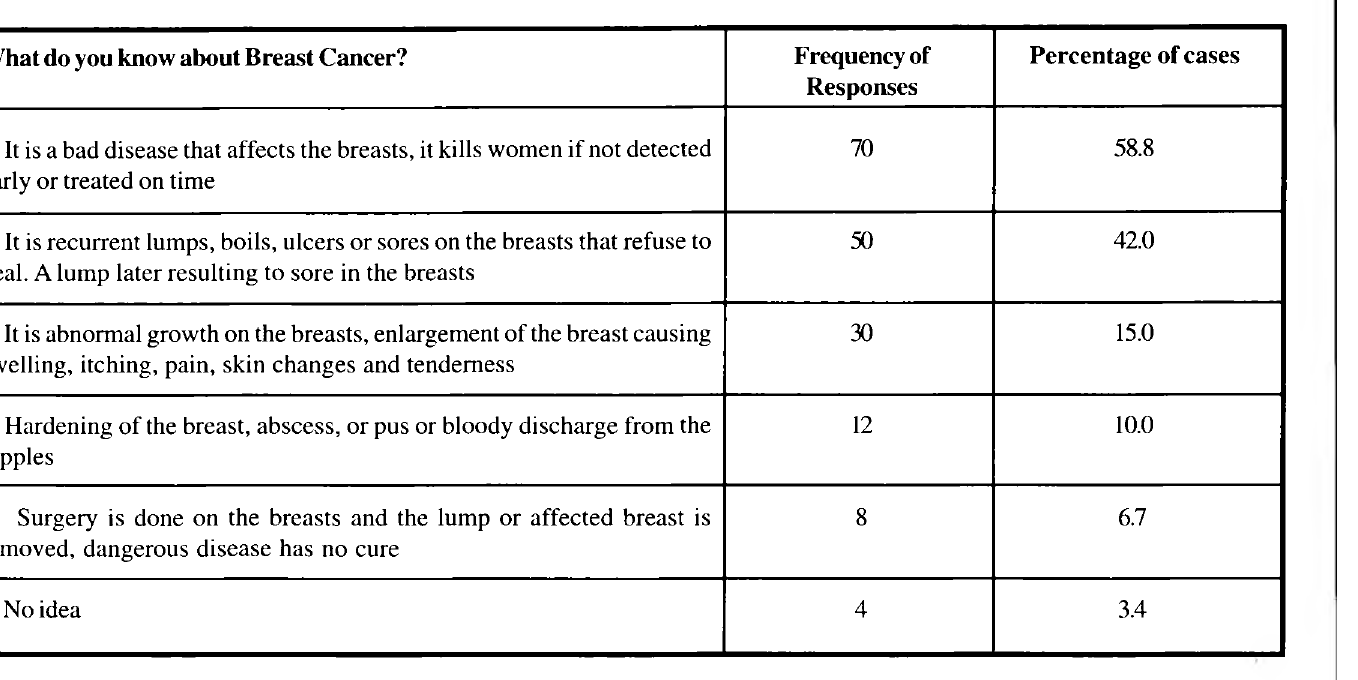
Table 1: Respondents’ Knowledge of Breast Cancer (N = 120) What do you know about Breast